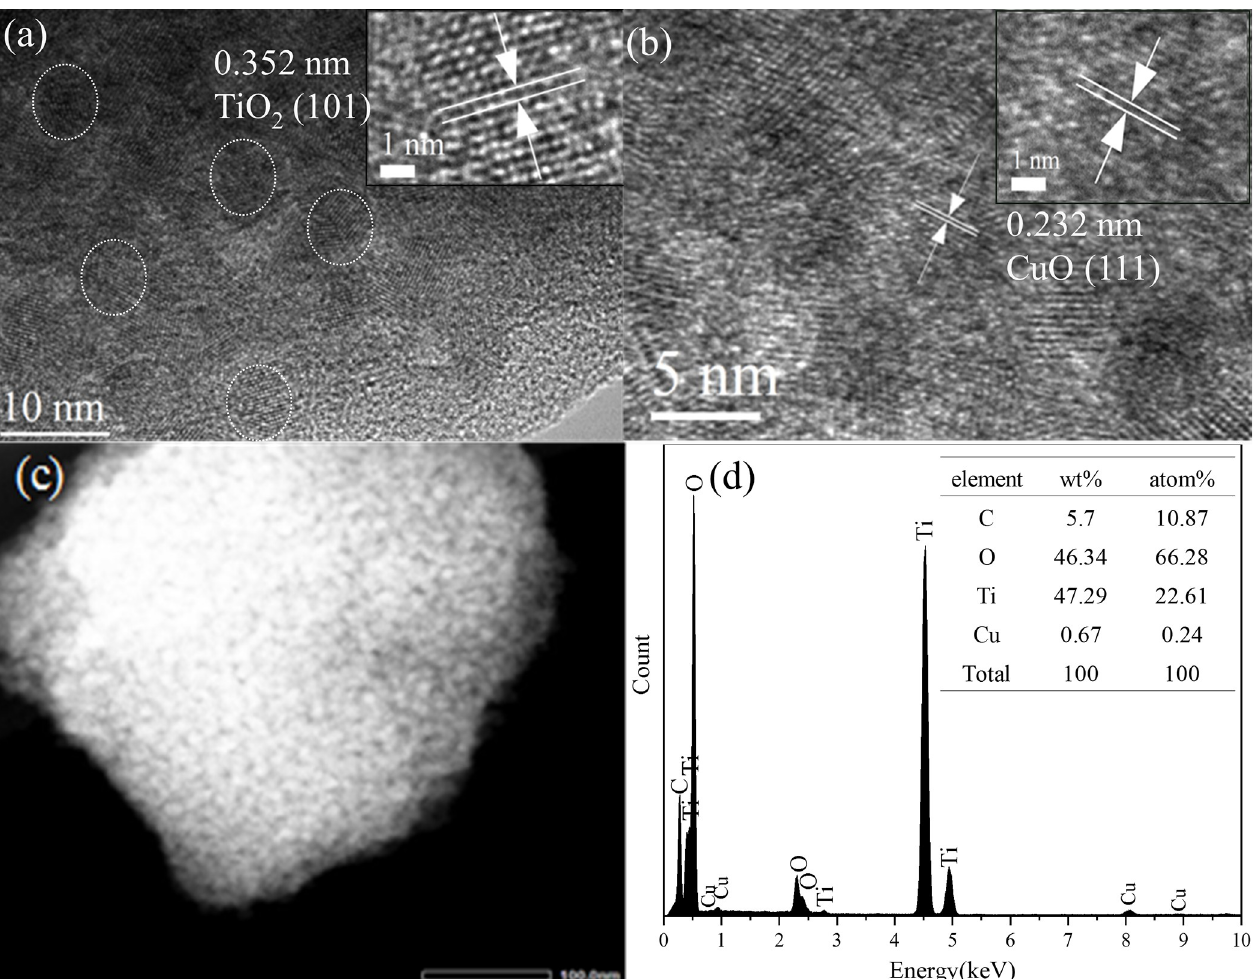
Fig 4. HRTEM images (a-b) of CuO x -CT400 and HAADF-STEM image (c) and EDX spectrum (d). The insets are the corresponding lattice fringes.